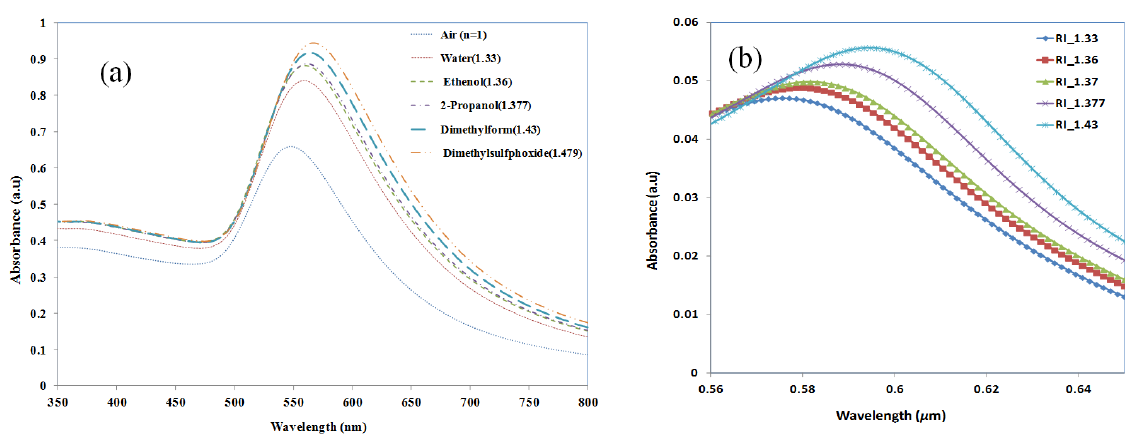
Figure 12. Shift of LSPR band in various solvents ( a ) measured and ( b )